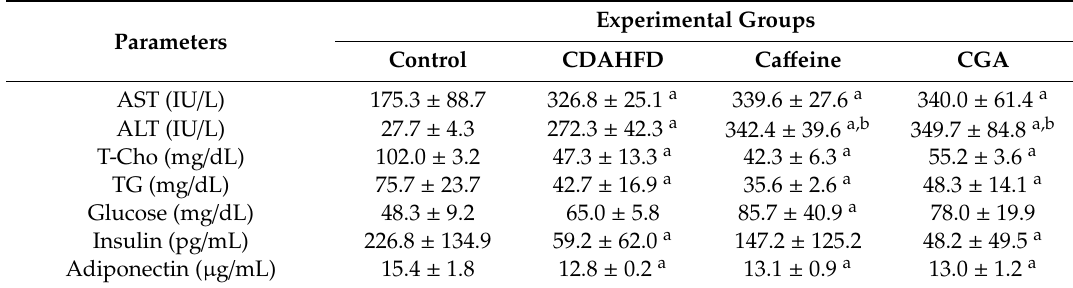
Table 3. Biochemical data of serum.